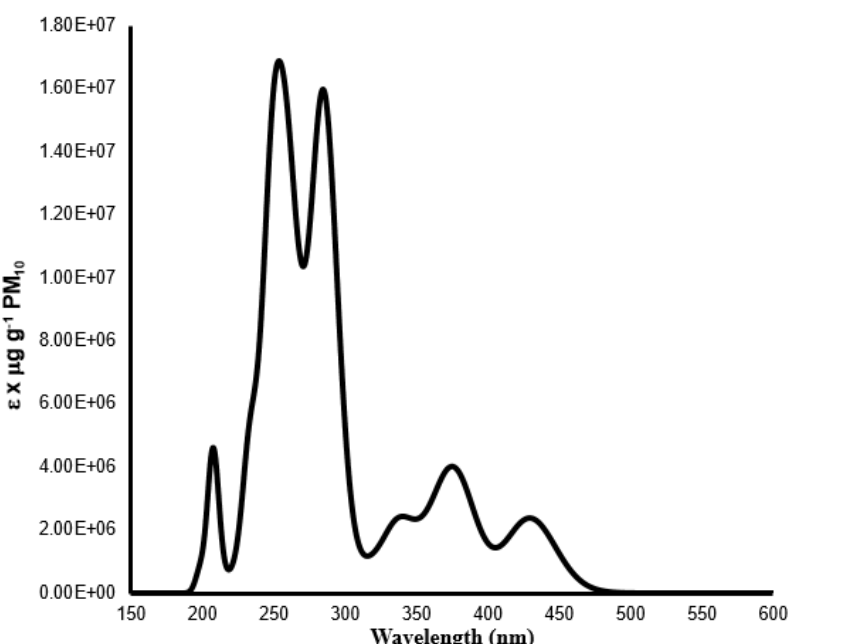
Figure 2. Combined theoretical absorption spectra of PAHs, when corrected for their experimental mean amount ( μ g g -1 PM 10 ) [38] over Porto, by using TD-PBE0/6-31+G(d,p).